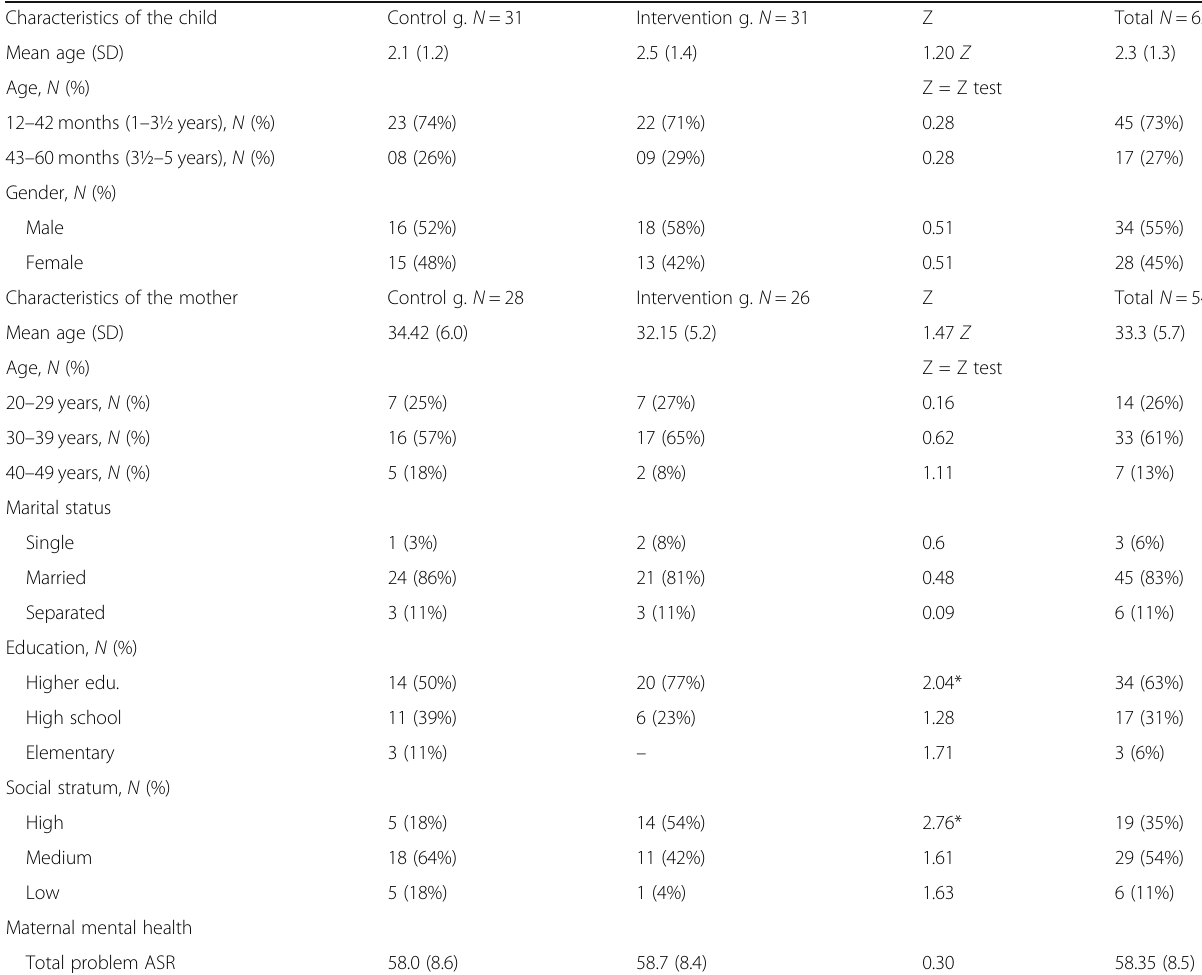
Table 2 Socio-demographic characteristics of the participants Characteristics of the